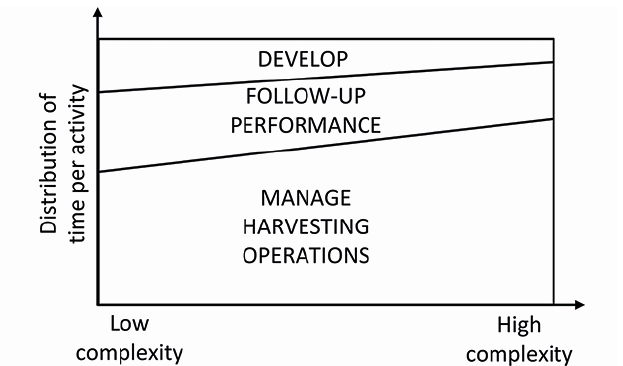
Figure 13. A visualization of the distribution of available time for different activities depending on the complexity in operational management (in principle, not by